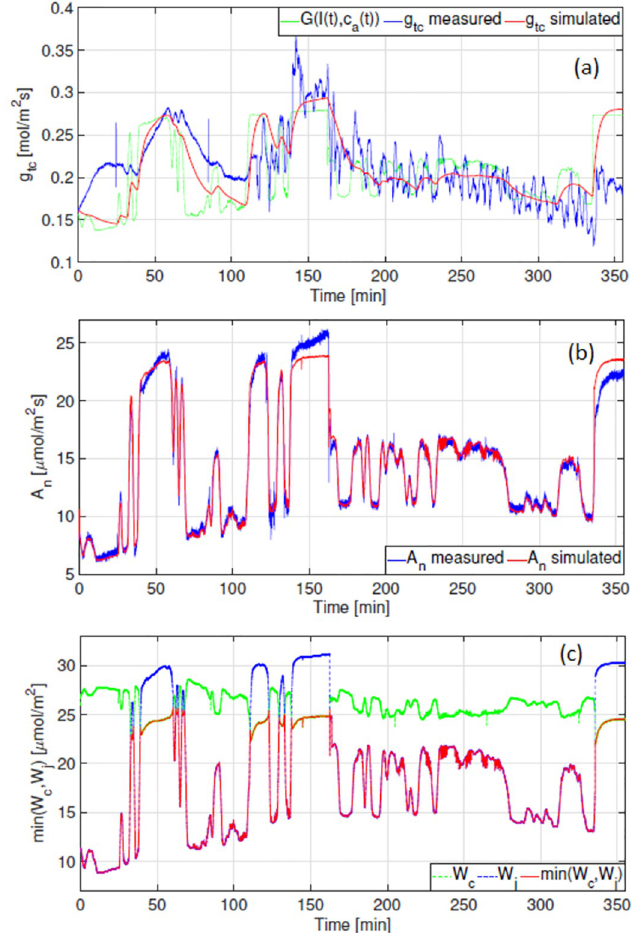
Fig 5. Results obtained after parameter estimation. (a) Total stomatal conductance to CO 2 diffusion molm − 2 s − 1 . (b) Net photosynthetic rate μmolm − 2 s − 1 (c) min(W c ,W j ) μmolm − 2 s − 1 , indicates whether photosynthesis is limited by the carboxylation or electron transport